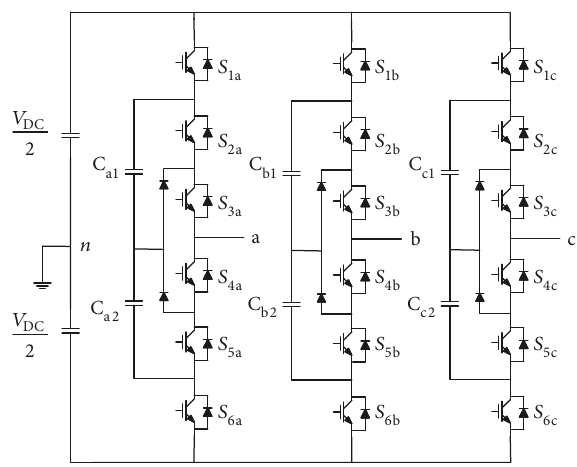
Figure 1: Schematic diagram of the four-level NNPC